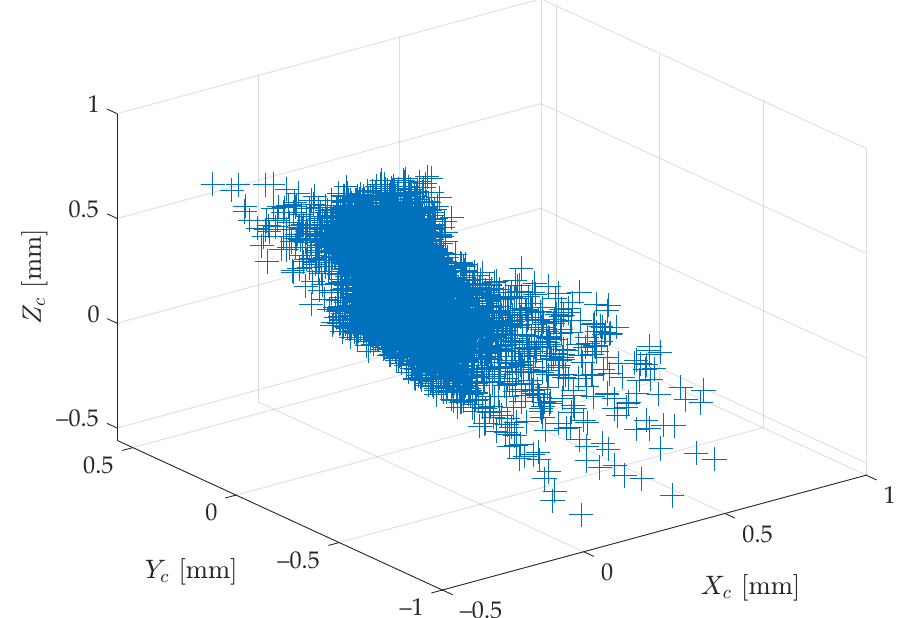
Figure 4. Dispersion of the M = 54 point-to-point errors in the 3D space—for a given set of N = 100 images—committed using an estimation of ( ω 1 , ω 2 , q ) yielded by (6) and expressed in the camera frame